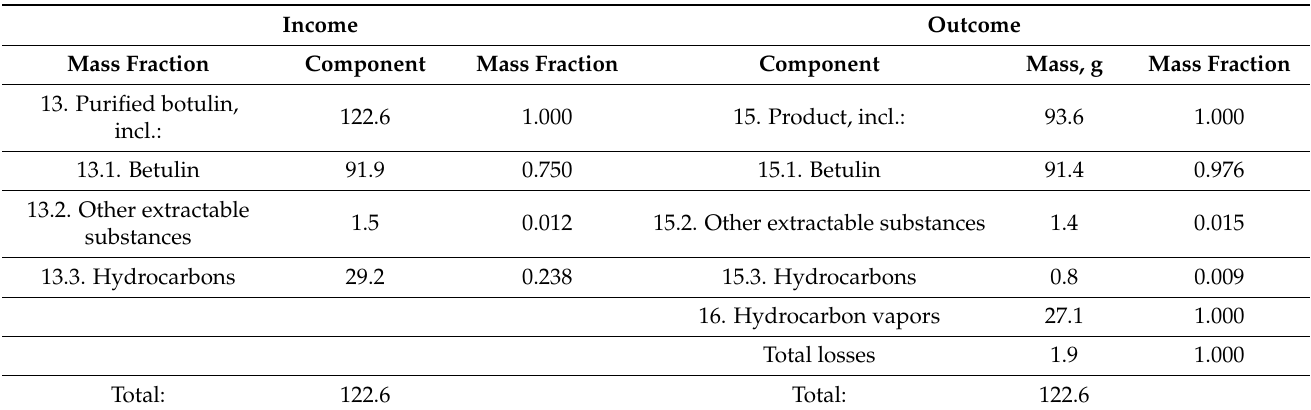
Table 8. Material balance of the drying process of purified